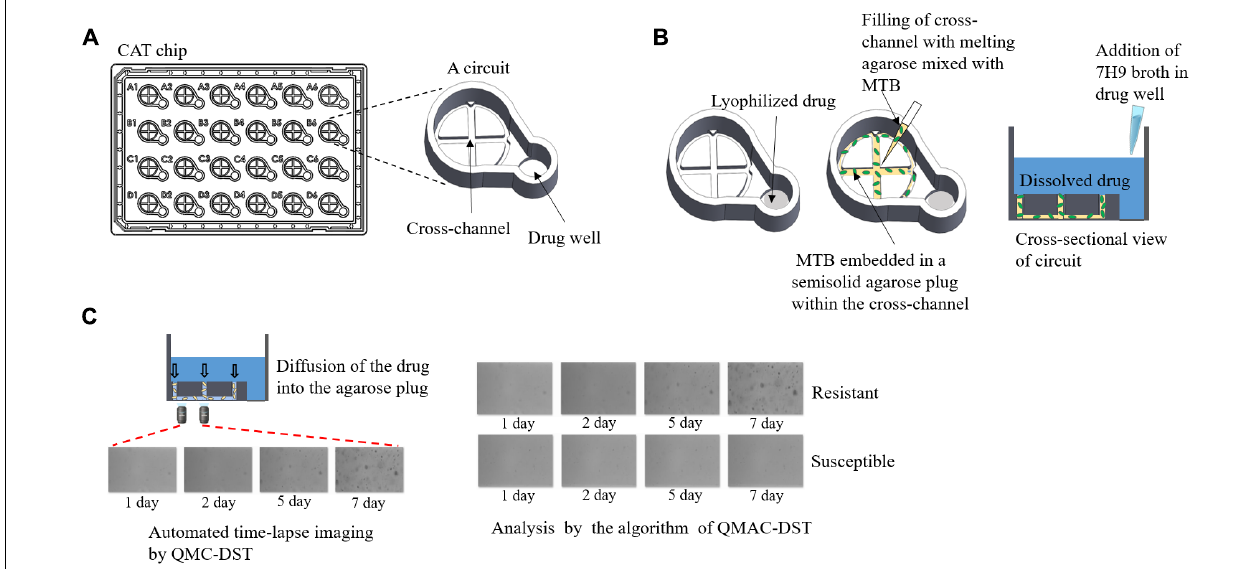
FIGURE 1 | QMAC-DST system for automated time-lapse imaging of CAT chips using image-processing software analysis. (A) Schematic representation of a CAT chip with 24 integrated reaction circuits, which is composed of a cross-channel for filling agarose-embedded Mycobacterium tuberculosis cells, and a well containing each lyophilized anti-tuberculosis drug. (B) After adding 7H9 broth containing 10% OADC, the 0.5% agarose plug filling the cross-channel allowed the dissolved drug to immediately reach the target concentration and make the drugs contact with the embedded Mycobacterium tuberculosis cells within a circuit. (C) For each circuit, two fields were taken for time-lapse images at fixed positions near the center of the left arm of the cross-channel on days 1, 2, 5, and 7 of incubation. Cumulative colony growth per each field was measured to determine resistant (cell growth) or susceptible (no growth) cells in the circuit using image analysis